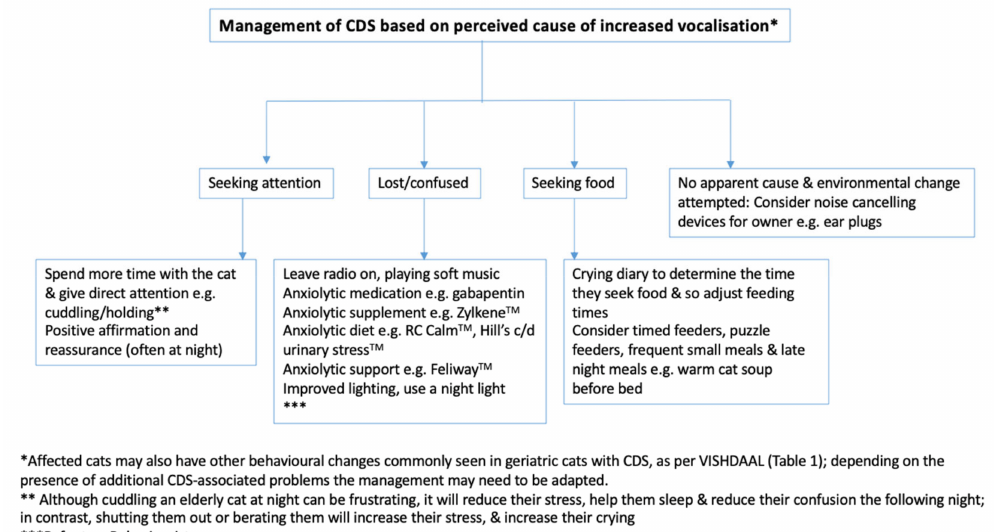
Figure 6. Algorithm for the management of the increased vocalisations associated with Cognitive dysfunction syndrome (CDS), targeting the potential cause, as perceived by the owners. This should be used in conjunction with CDS therapeutics as described